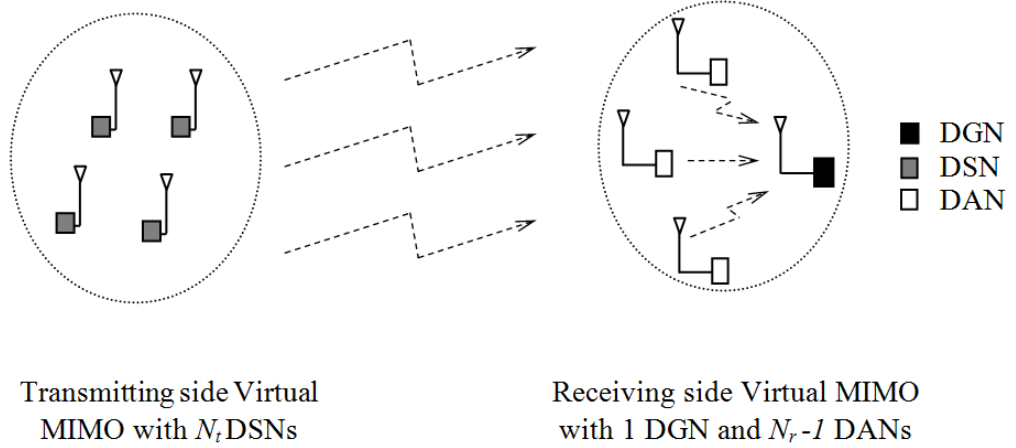
Figure 4. Communication between Transmitting and Receiving side Virtual MIMO